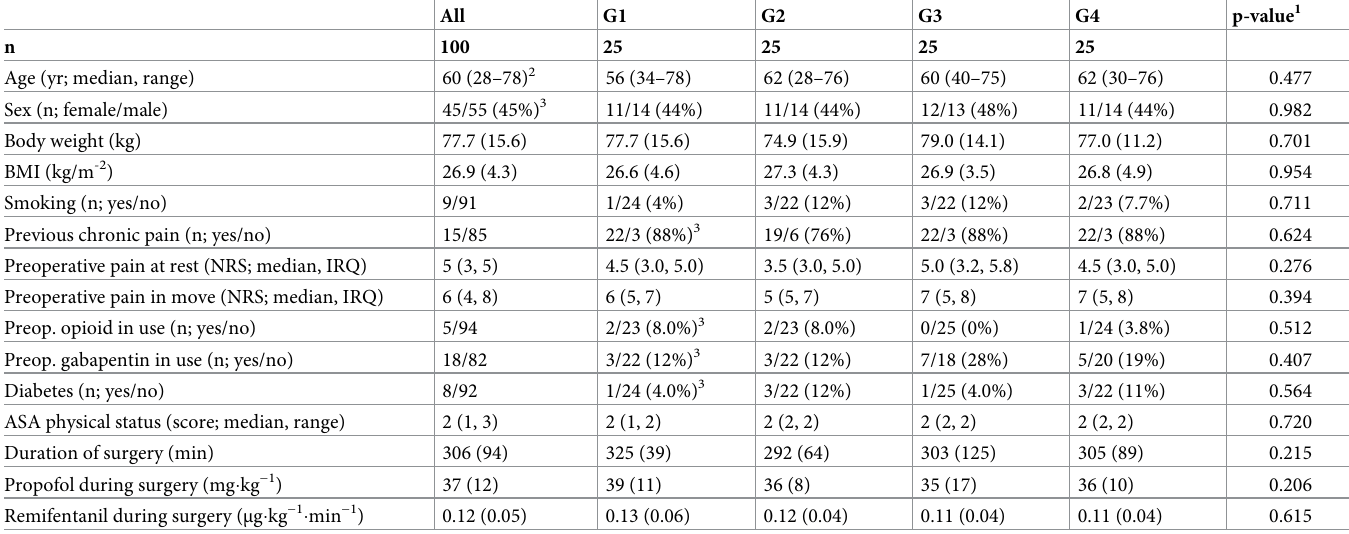
Table 1. Perioperative data and characteristics of patients who were included in the analysis. All